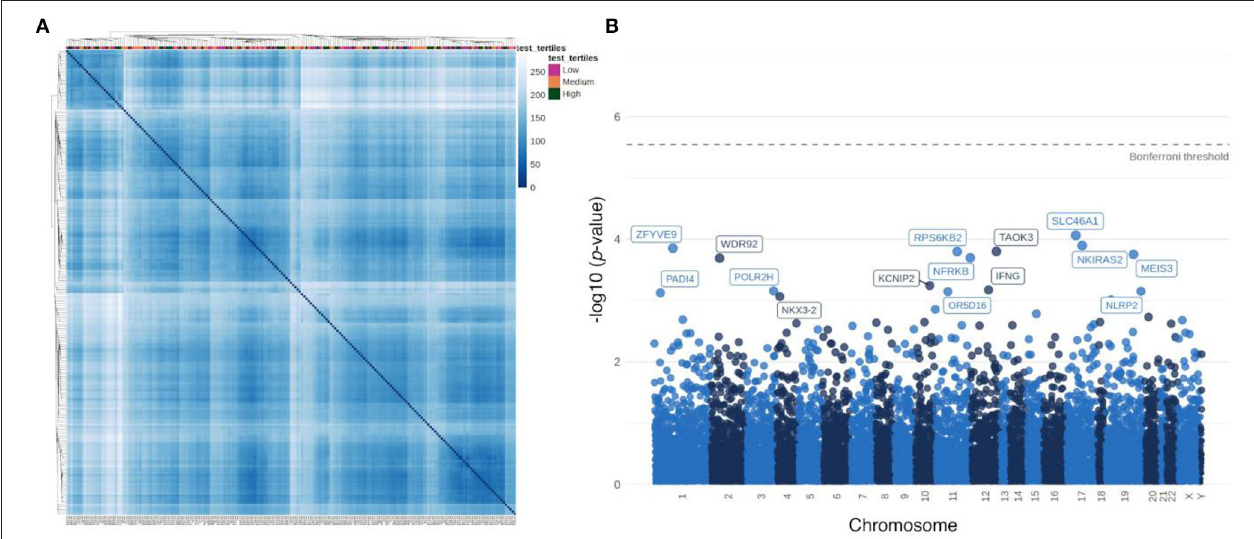
FIGURE 3 | Association of testosterone levels with transcriptome signatures in male plaque tissue. (A) Heatmap based on sample-to-sample distances colored by continuous testosterone levels. (B) Manhattan plot of associations between testosterone levels and individual gene expression.